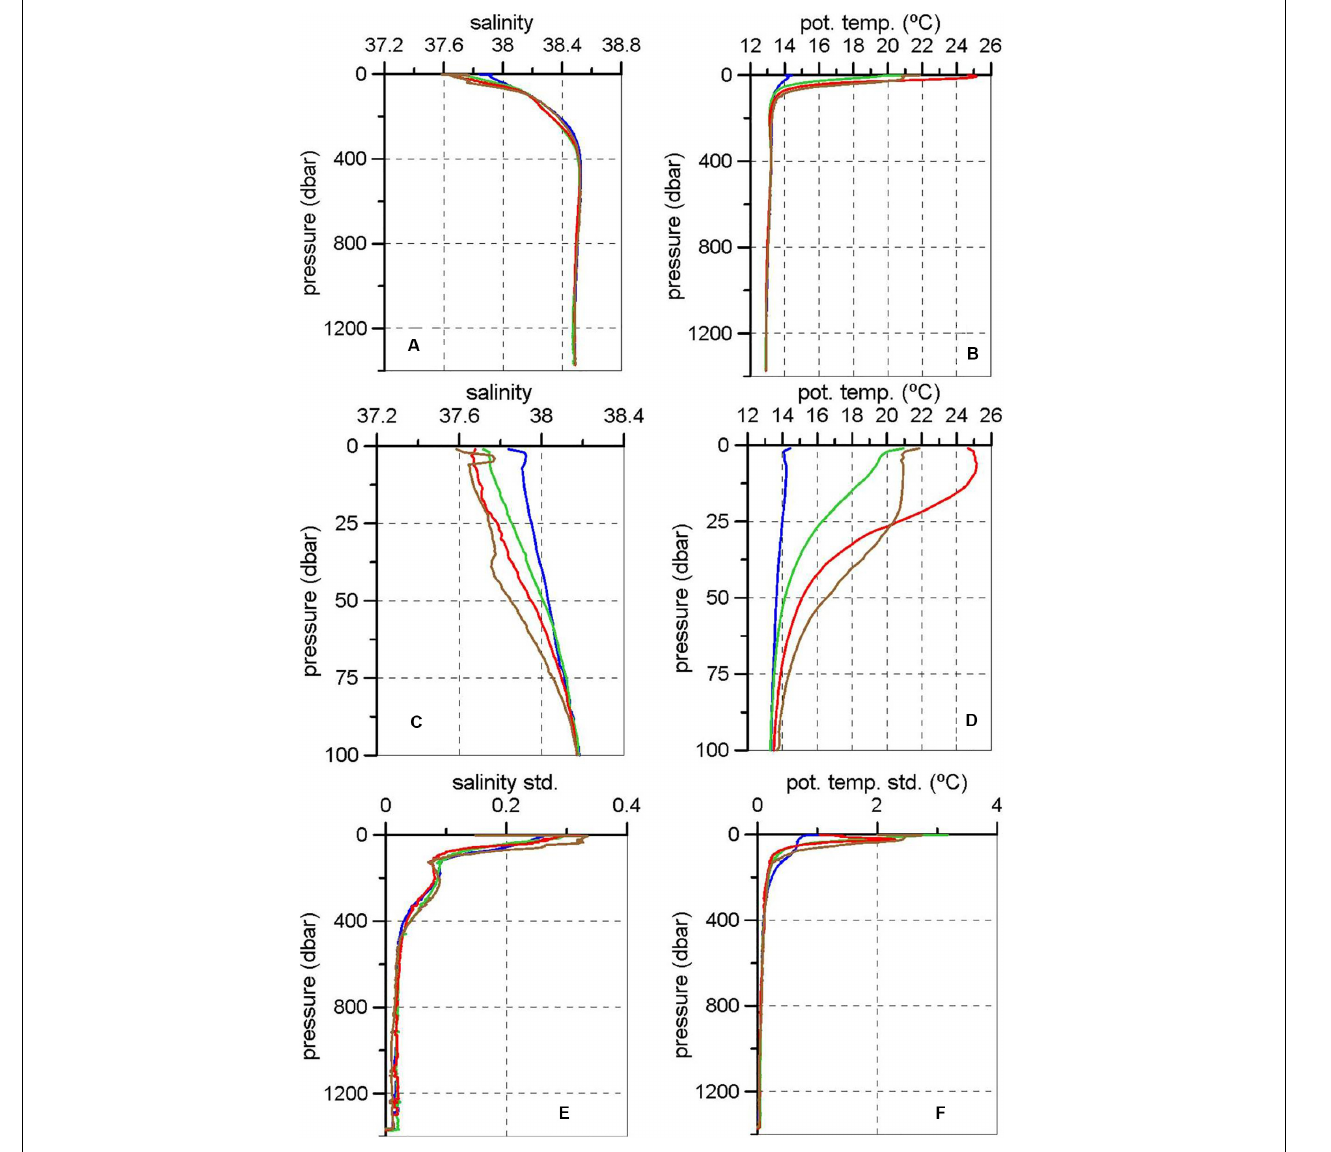
FIGURE 3 | Median vertical profiles of salinity (A) and potential temperature (B) for each season of the year for the four hydrographic sections, and respective zooms in the upper 100 dbar (C,D) . Vertical profiles for the salinity and potential temperature standard deviation ( E,F , resp.). Seasons are indicated in color: winter (blue), spring (green), summer (red), and autumn (brown).